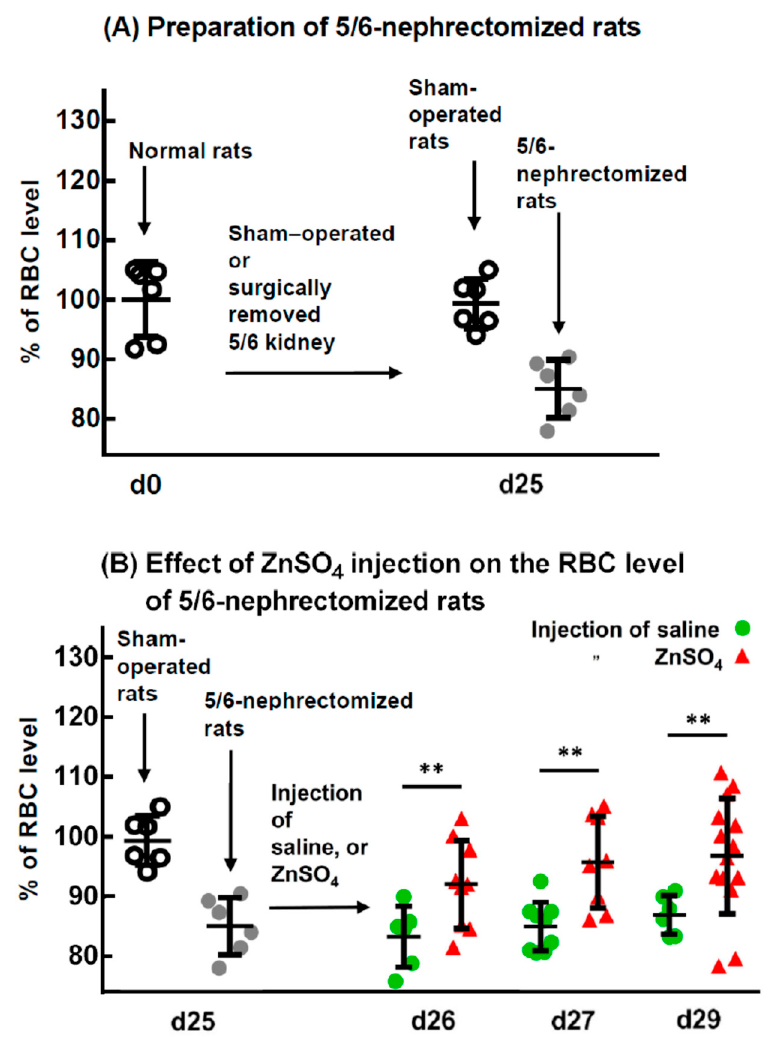
Figure 1. Preparation of 5/6-nephrectomized rats and the effect of ZnSO 4 injection on their red blood cell (RBC) levels. ( A ) Normal rats underwent a sham-operation or surgical removal of 5/6 of the kidney. After 25 days, rat blood was drawn, and RBC levels and other hematological indices of the rats were measured. ( B ) Effect of ZnSO 4 injection on the RBC level of 5/6-nephrectomized rats. The 5/6-nephrectomized rats (25 days post surgery) were injected with either saline or 2.8 mg Zn/kg body weight of ZnSO 4 solution. One, 2, or 4 days after injection, RBC levels and other hematological indices were measured. ** Significant difference between ZnSO 4 -injected and saline-injected rats (p < 0.01, n = 6). This figure is representative of three independent experiments.